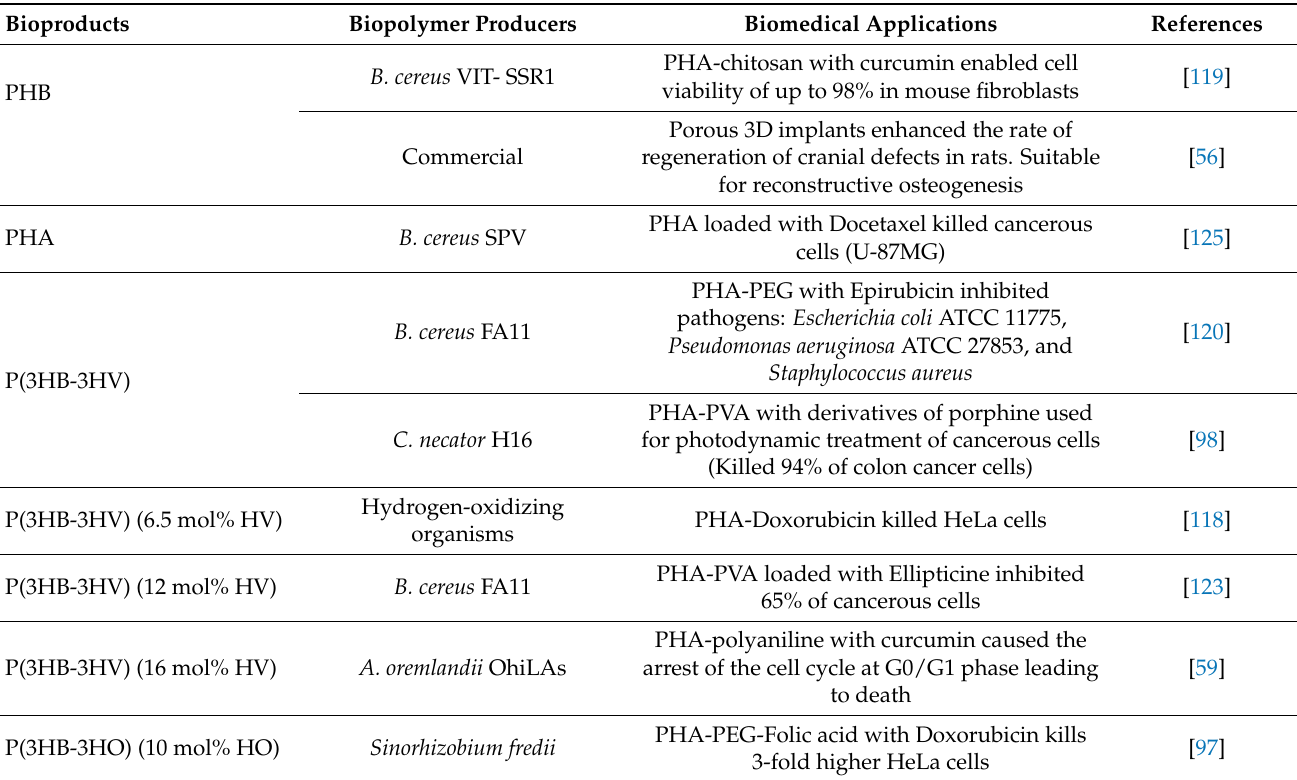
Table 2. Diversity of biomedical applications of polyhydroxyalkanoates and their derivatives in drug carriers and